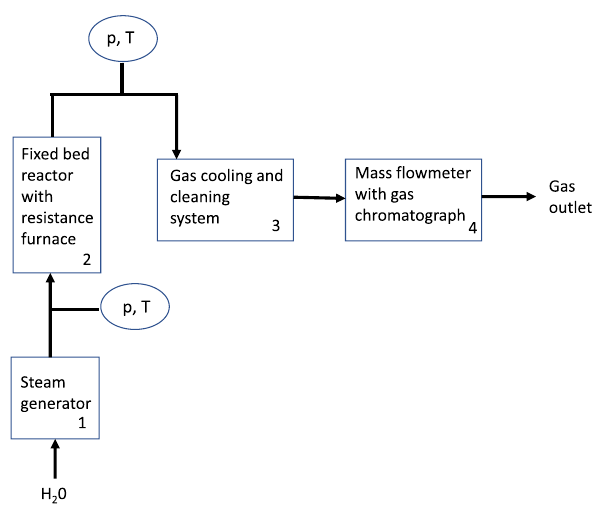
Fig.1 Scheme of the gasification installation: (1) gasification agent supply with steam generator, (2) fixed bed reactor with resistance furnace, (3) gas cooling and cleaning system, (4) gas chromatograph (GC) with a flow rate measurement system